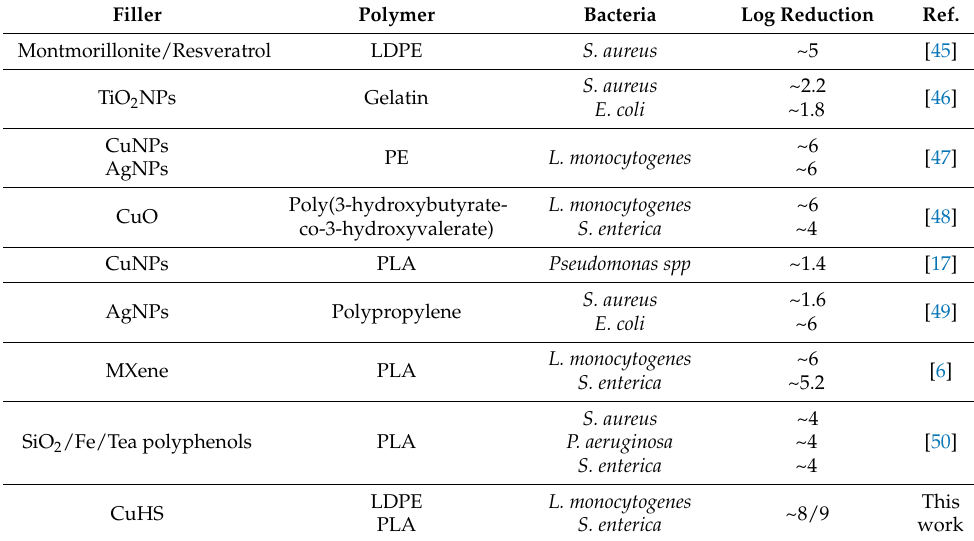
Table 3. Polymeric matrix/filler antibacterial systems (maximum values) reported in the literature using the surface contact test method.